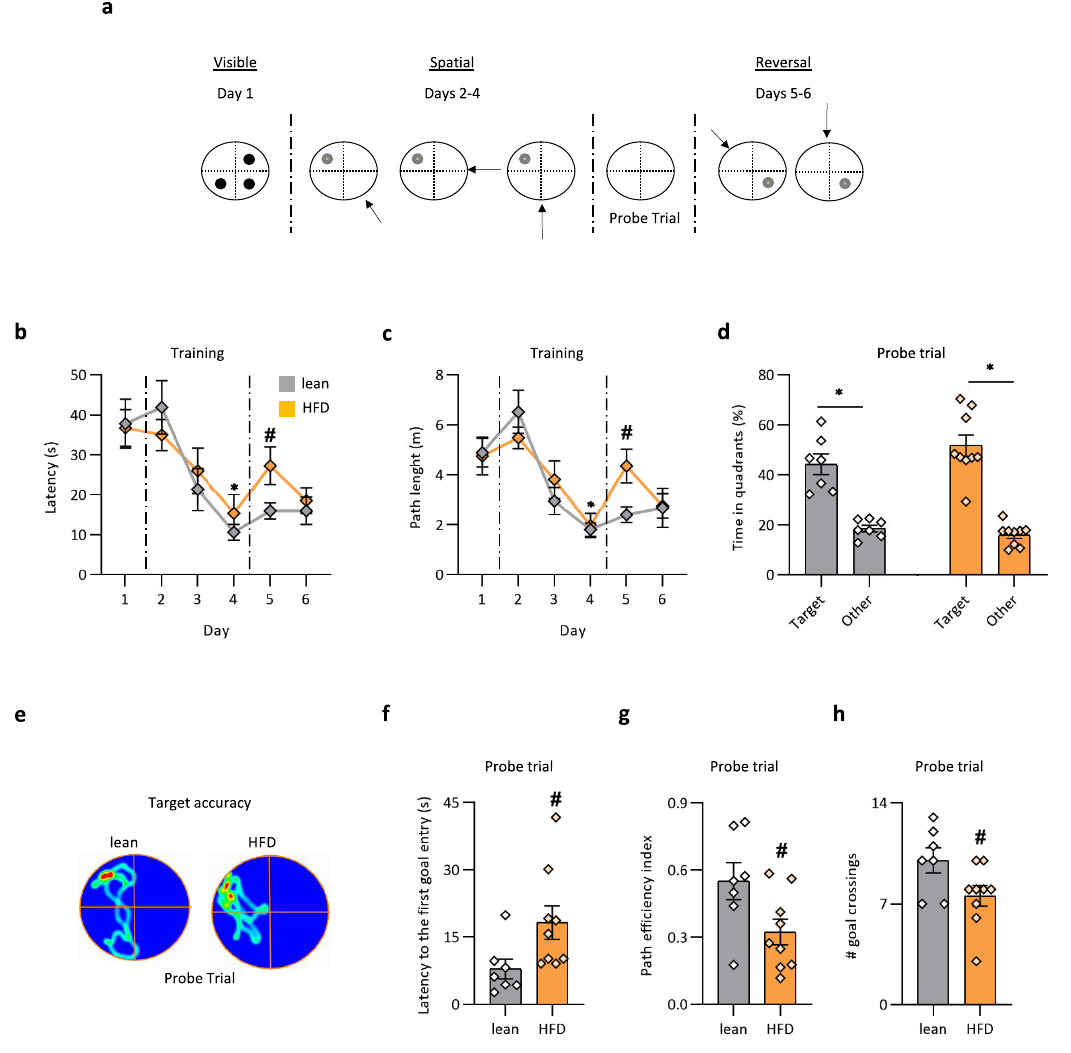
Fig. 2 Differences in spatial learning abilities of lean and HFD mice in the water maze. a Schematic representation of the water maze protocol (the black and gray dot inside the pool represents the position of the visible and hidden platform, respectively). b , c Latency and path lengths to reach the platform during the visible task and training. ANOVA test and Bonferroni post hoc test; latency * p < 0.0001; F = 24.37; path length * p < 0.0001; F = 22.89; n = 7 lean mice and n = 9 HFD mice. d Percentage of time spent in the target quadrant compared to the others during the probe trial (lean: target quadrant = 44.29% ± 4.1%, other quadrants = 18.57%± 1.3%; HFD: target quadrant = 51.72% ± 4.3% and other quadrants = 16.07% ± 1.4%. ANOVA test and Bonferroni post hoc test, * p < 0.0001; F = 56.9; n = 7 lean mice and n = 9 HFD mice. e Representative target accuracy in the probe trial was indicated by heat maps. Dark red zones represent a sixfold presence probability. f − h Latency to the fi rst goal entry (lean = 7.9 ± 2.1, HFD = 18.21 ± 3.7; # p < 0.05; F = 4.88), path ef fi ciency (lean = 0.5 ± 0.08, HFD = 0.3 ± 0.05; # p < 0.05; F = 5.55) and goal crossings ( # p < 0.05; F = 4.82; lean = 10 ± 0.8, HFD = 7.5 ± 0.7) are all measures related to a precise localization of the platform position in the quadrant during the probe trial. Histograms represent mean ± SEM. *comparison within the groups; # comparison between the groups. n = 7 lean mice and n = 9 HFD mice. Source data are provided as a Source Data fi